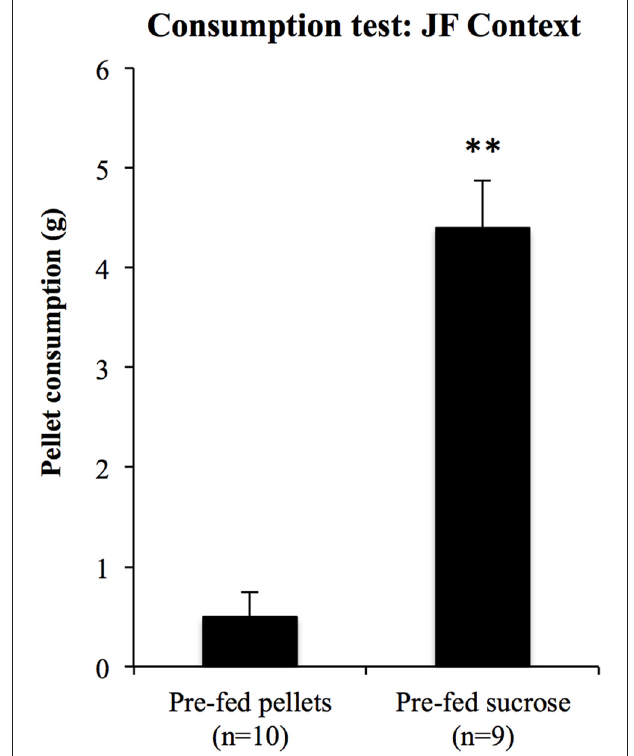
FIGURE 8 | Devaluation tests in the Chow context. Performance was sensitive to outcome devaluation and unaffected by which cue was presented when rats were tested in the chow context, despite an overall reduction in responding from the first set of tests. ∗ Indicates p = 0.015 for devaluation effect.